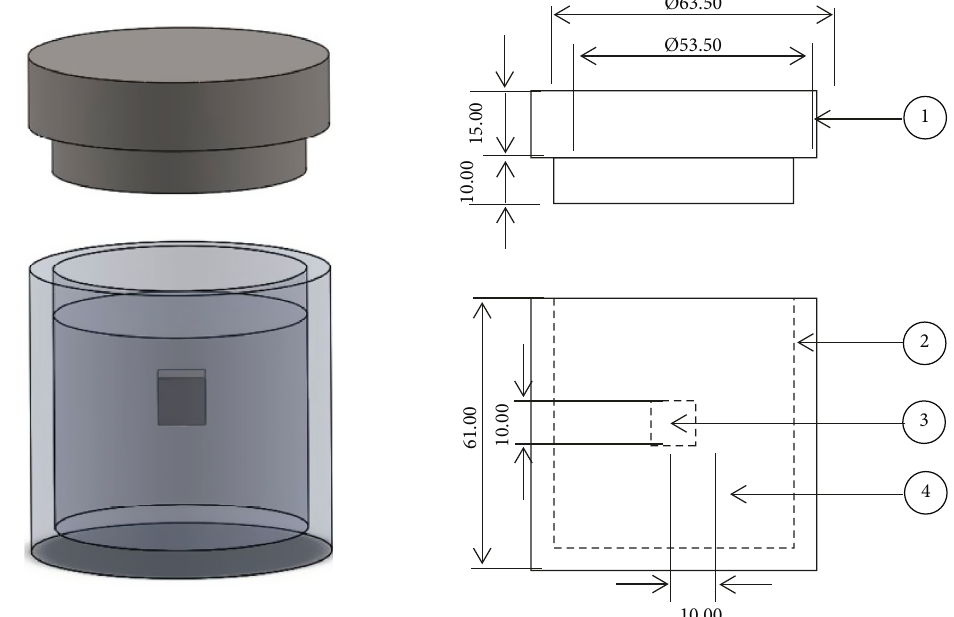
Figure 2: Schematic view of the stainless steel AISI 316L container for the pack-powder boriding treatment (1: lid; 2: powder boriding medium (B 4 C +KBF 4 +SiC); 3: sample; 4: container) (millimeter scale) [29,